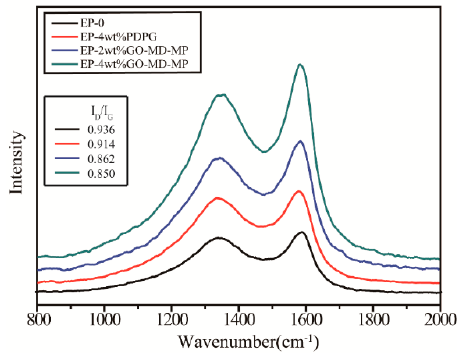
Figure 13. Raman spectra of different cured EP composites residue chars.